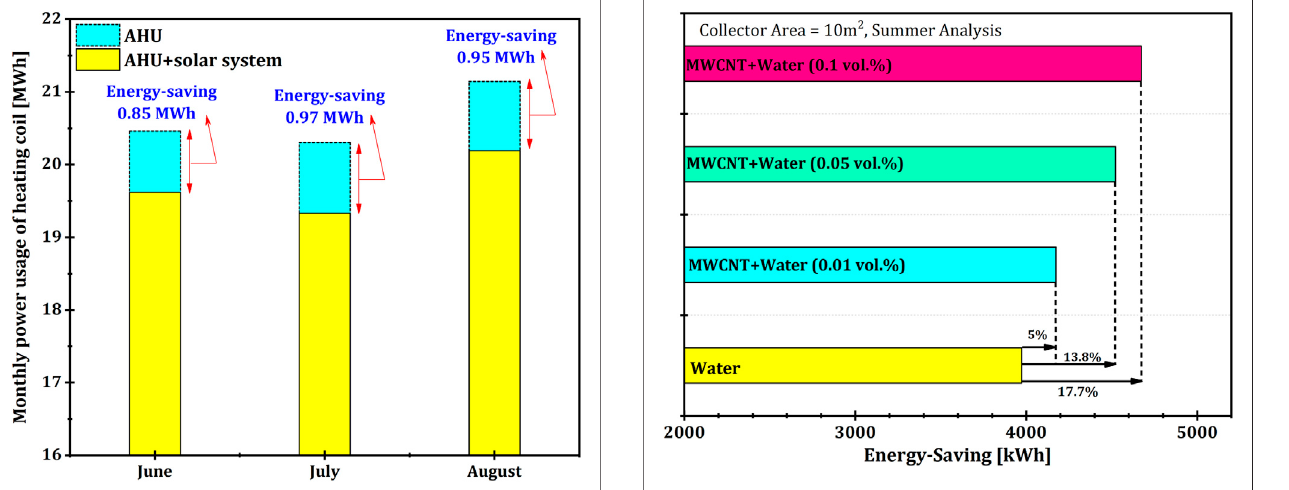
FIGURE 13 | Energy-saving increase owing to adding MWCNT/water in